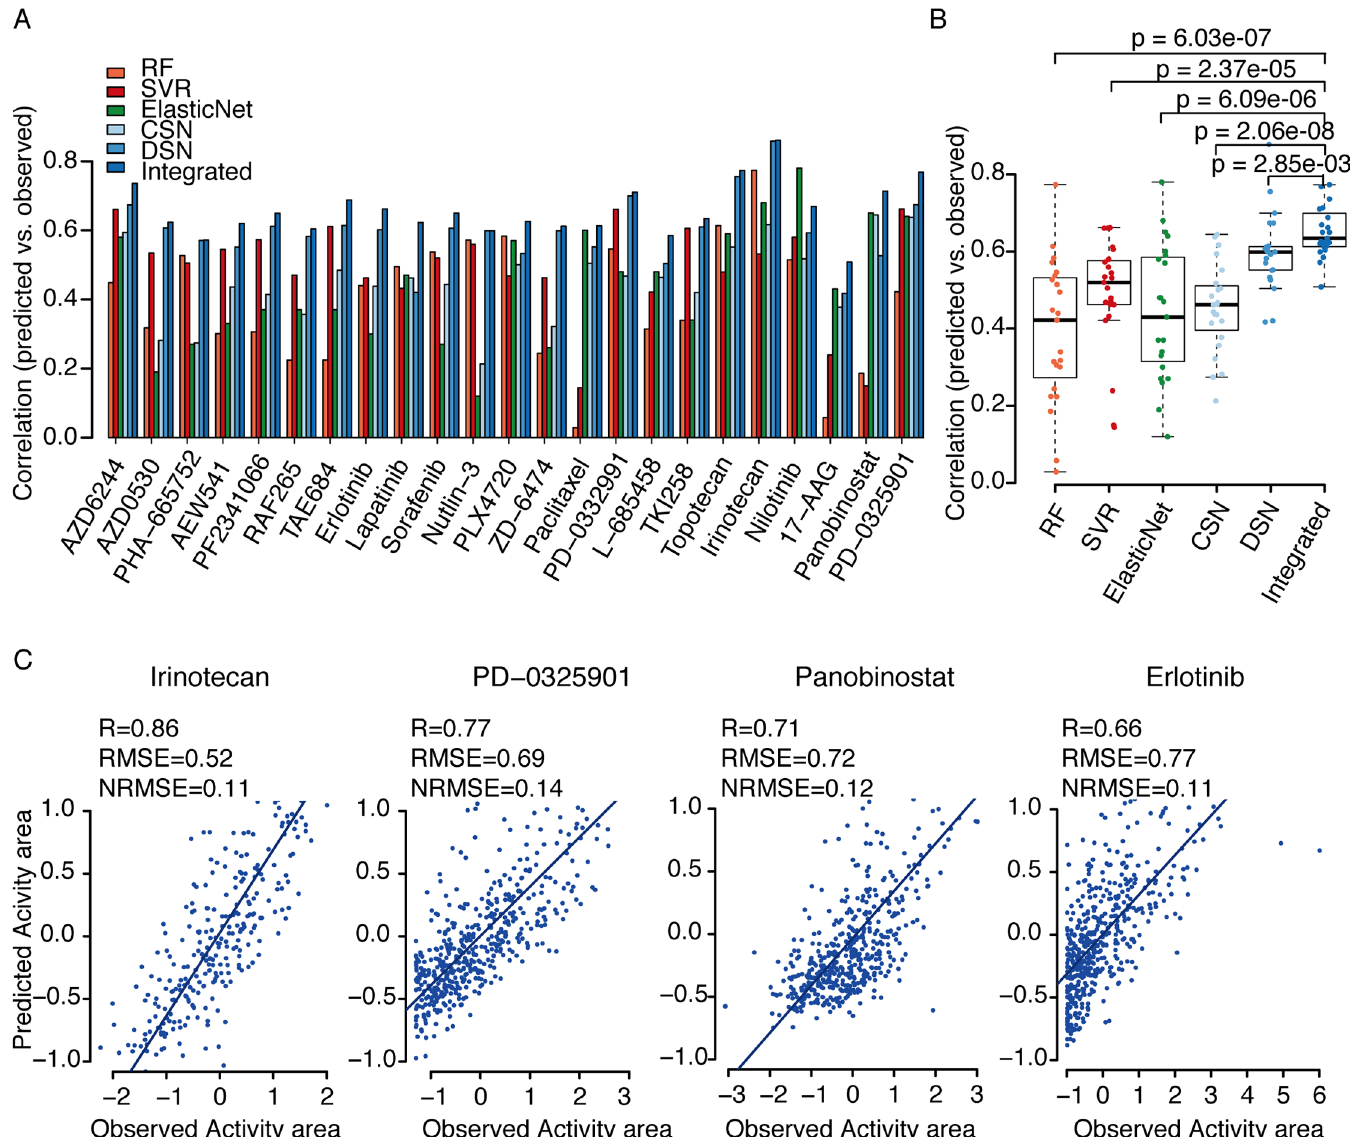
Fig 4. Prediction performance of the dual-layer integrated cell line-drug network model using the CCLE dataset. (A) Bar graph showing the prediction performance of six different models for 23 drugs tested in the CCLE study, which were quantified based on Pearson correlations between the predicted and observed activity areas. RF: prediction result by random forest using combined features of genomic and chemical data; SVR: prediction result by support vector regression using combined features of genomic and chemical data; CSN: prediction result using only the cell line similarity network; DSN: prediction result using only drug similarity network; ElasticNet: result from the CCLE study using the elastic net model; Integrated: prediction result using the dual-layer integrated cell line-drug network model that integrates CSN and DSN; (B) Pearson correlation distributions of the RF, SVR, CSN, DSN, ElasticNet and Integrated models, where t-tests were used to measure differences between two different groups. (C) Scatter plots of observed and predicted drug responses (activity area) for four drugs in CCLE using the dual-layer integrated cell line-drug network model.